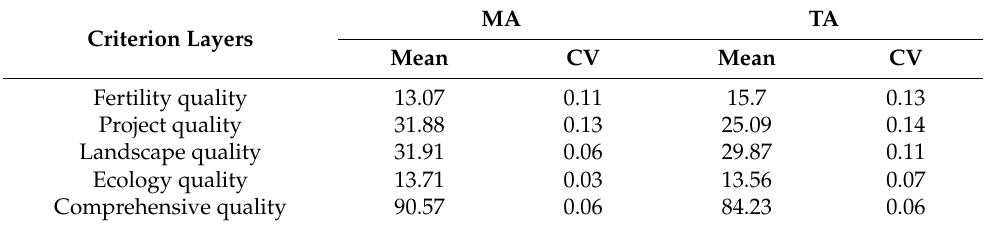
Table 4. The CV of CLQ in MA and TA.